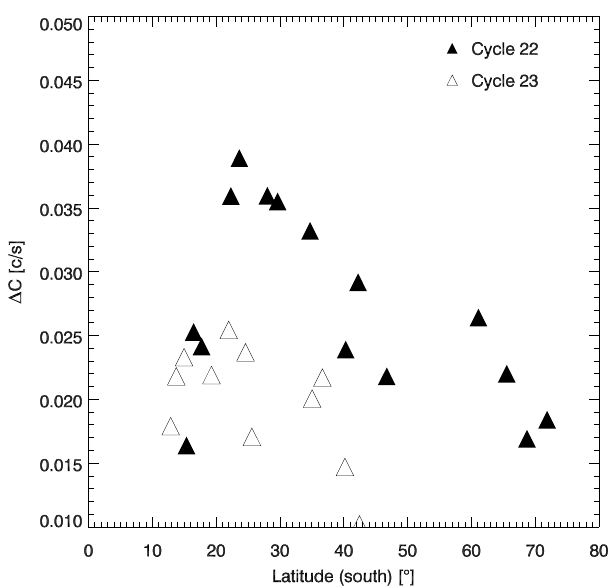
Fig. 4. Evolution of the amplitude, 1c , of recurrent GCR de- creases for daily averaged 250-2000 MeV COSPIN/KET protons. The filled and open triangles represent the variations during the time intervals C22/P1+P2 and C23/P1+P2, respectively.